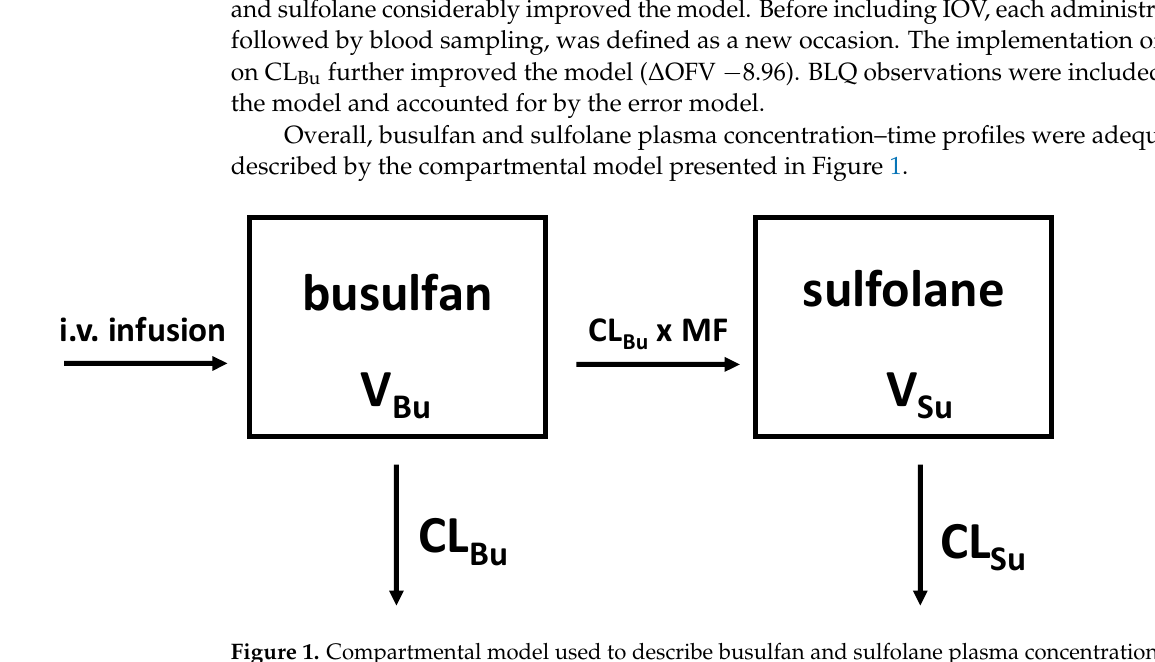
Figure 1. Compartmental model used to describe busulfan and sulfolane plasma concentration–time profiles. CL Bu : busulfan clearance, representing the total clearance; V Bu : volume of distribution of busulfan; MF: metabolic fraction; CL Su : sulfolane clearance; V Su : volume of distribution of sulfolane; formation of sulfolane as part of the total clearance.